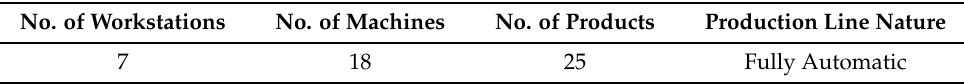
Table 1. Production Line